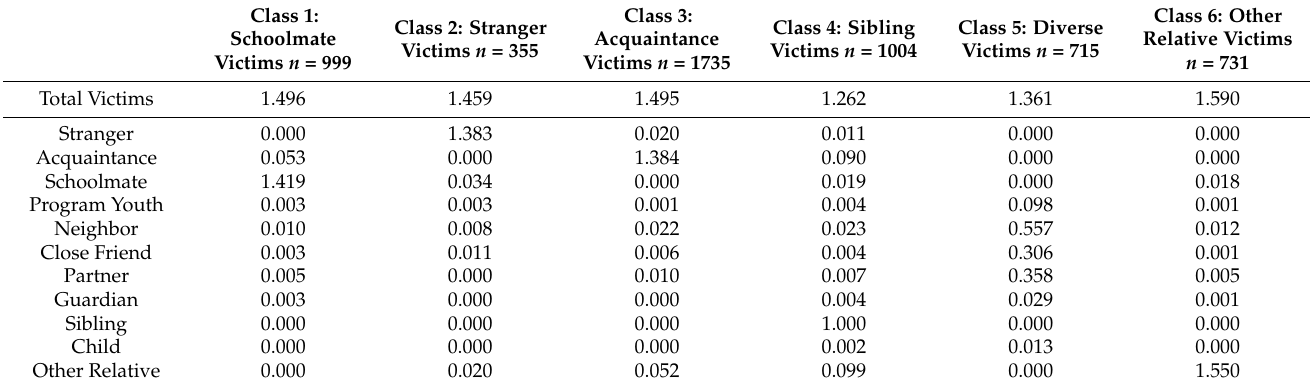
Table 3. Description of victim associations among